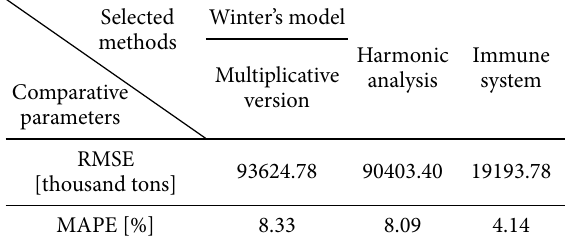
Table 3. Comparison between selected forecasting methods